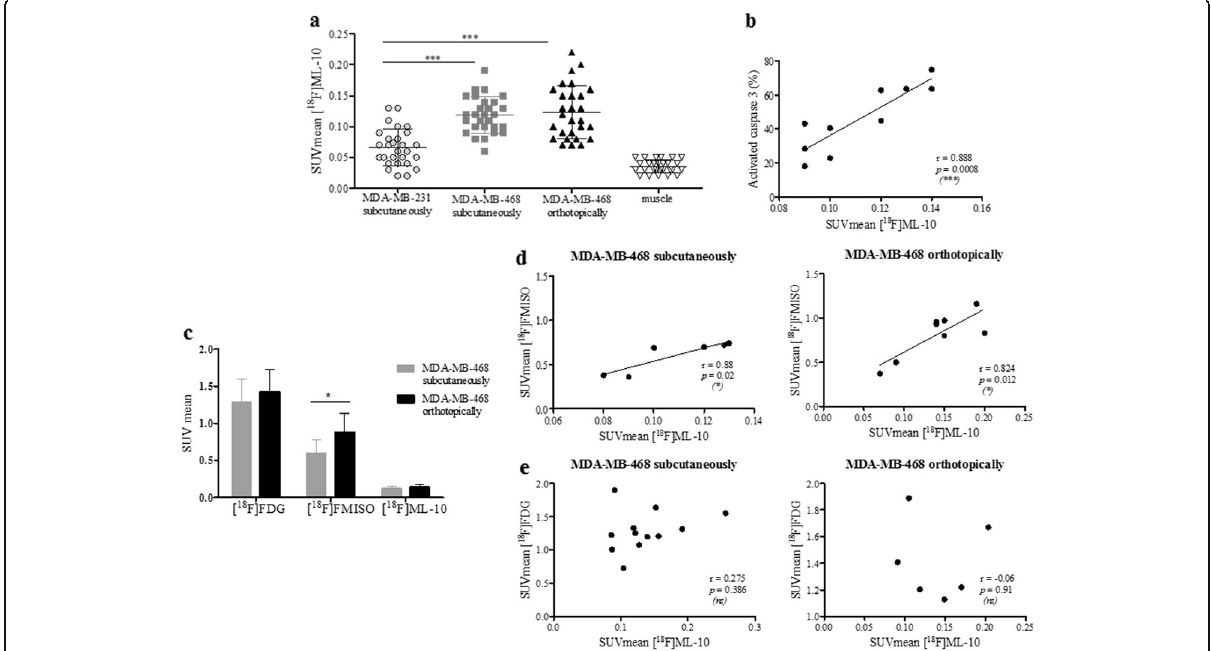
Fig. 7 In vivo imaging analysis of baseline PET imaging. a SUVmean showing uptake of [ 18 F]ML-10 in MDA-MB-231 subcutaneous xenograft tumor, MDA-MB-468 subcutaneous xenograft tumor, and MDA-MB-468 orthotopic xenograft tumor and muscle. The Mann-Whitney test was performed (*** p < 0.001). b Flow cytometric quantitation of cell apoptosis was compared with cell-associated radioactivity for [ 18 F]ML-10. Pearson correlation was performed (*** p < 0.001). c SUVmean showing uptake of [ 18 F]FDG, [ 18 F]FMISO, and [ 18 F]ML-10 in MDA-MB-468 subcutaneous or orthotopic xenograft tumor. The Mann-Whitney test was performed (* p < 0.05, ** p < 0.01, *** p < 0.001). Correlation SUVmean of [ 18 F]FDG d or [ 18 F]FMISO e uptake in tumor with SUVmean of [ 18 F]ML-10. Pearson correlation was performed (* p < 0.05)